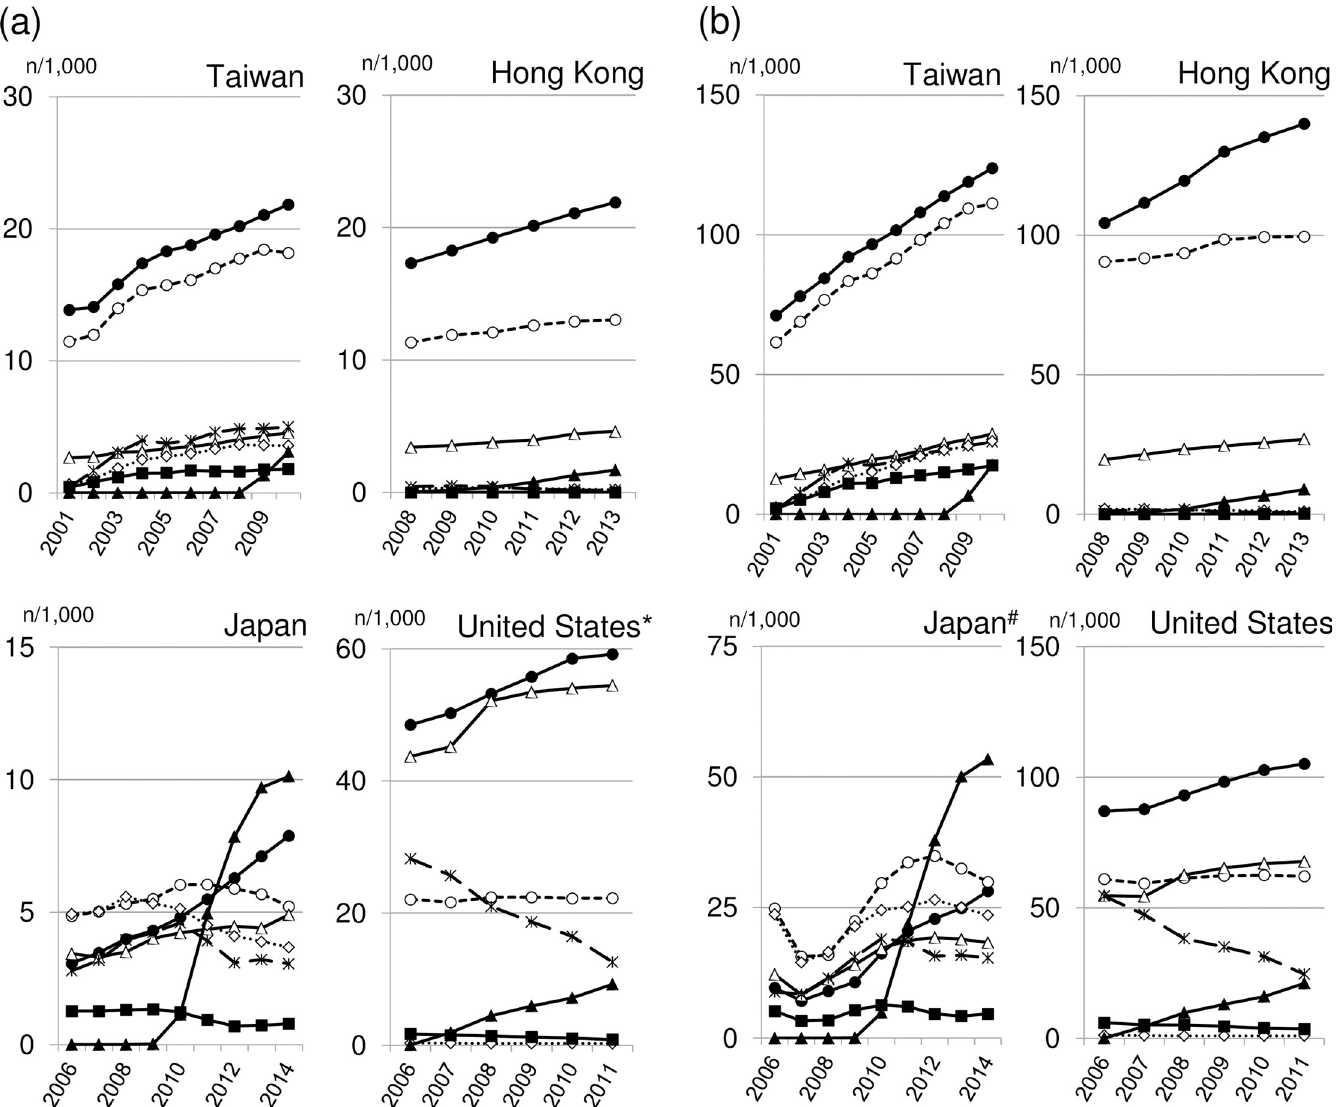
Fig 1. Prevalence per 1000 patients of the use of biguanides ( ● ), sulphonyl urea ( � ), insulin ( 4 ), thiazolidinediones ( × ), alpha-glucosidase inhibitors ( � ), meglitinides ( ■ ) and dipeptidyl peptidase 4 (DPP-4) inhibitors ( ▲ ) in Taiwan, Hong Kong, Japan, and the United States. Panel A shows patients younger than 65 years; Panel B shows patients 65 years or older. � The study population is not representative of the corresponding age group in the general population in the United States (see text for details). † The study population is not representative of the corresponding age group in the general population in Japan (see text for details).